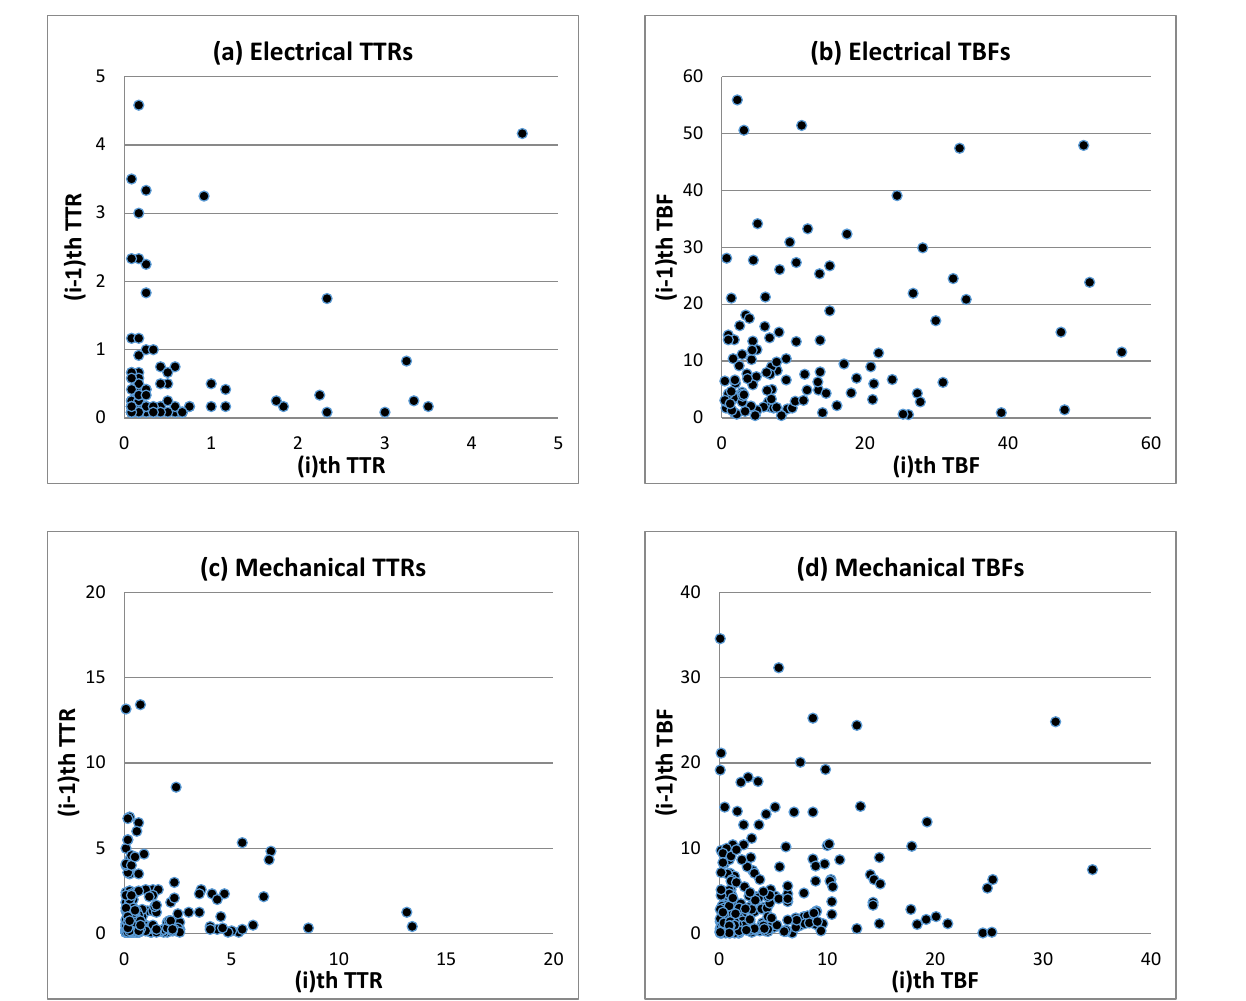
Figure 6. Serial correlation test on TBFs and TTRs of electrical and mechanical EPBM subsystems.